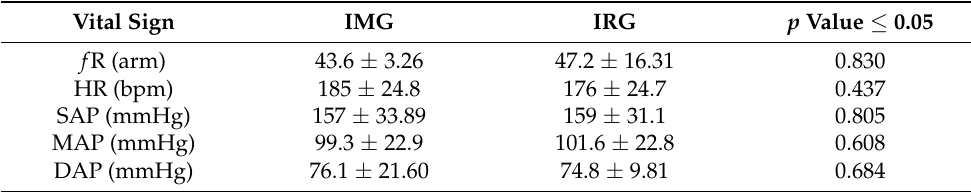
Table 2. Vital signs at general examination (pre-drug administration, T0 time point) in the intramus- cular group (IMG) and rectal group (IRG). Respiratory rate ( f R), heart rate (HR), sistolic (MAP), mean (MAP), and diastolic (DAP) pressure are presented by mean and standard deviation in IMG and IRG and relative p value (any statistically difference). Vital Sign IMG IRG p Value ≤ 0.05